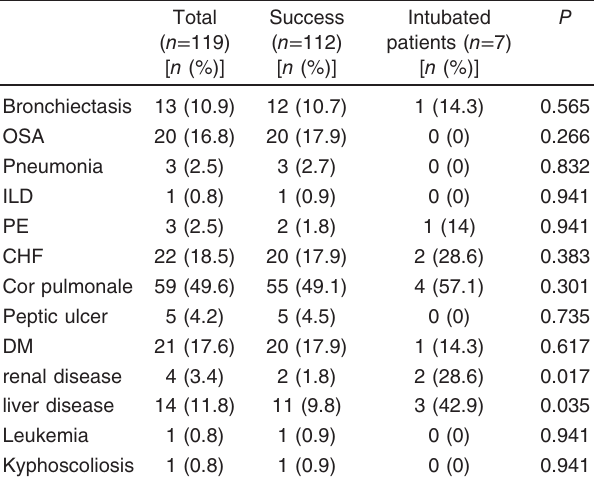
Table 4 Comorbidities in the success and failure groups